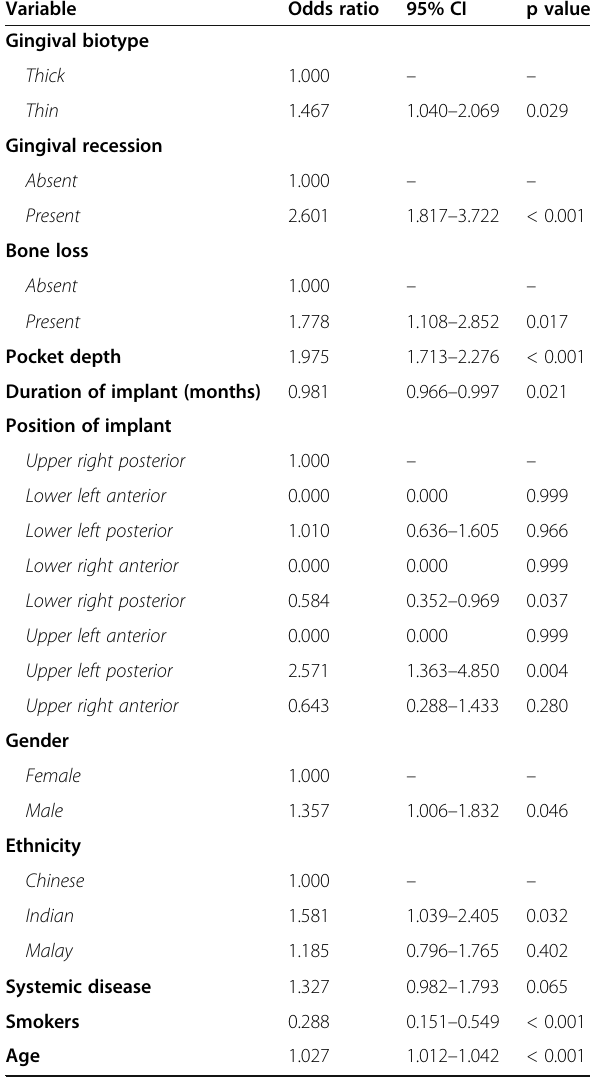
Table 2 Results of bivariate analysis referring to bleeding on